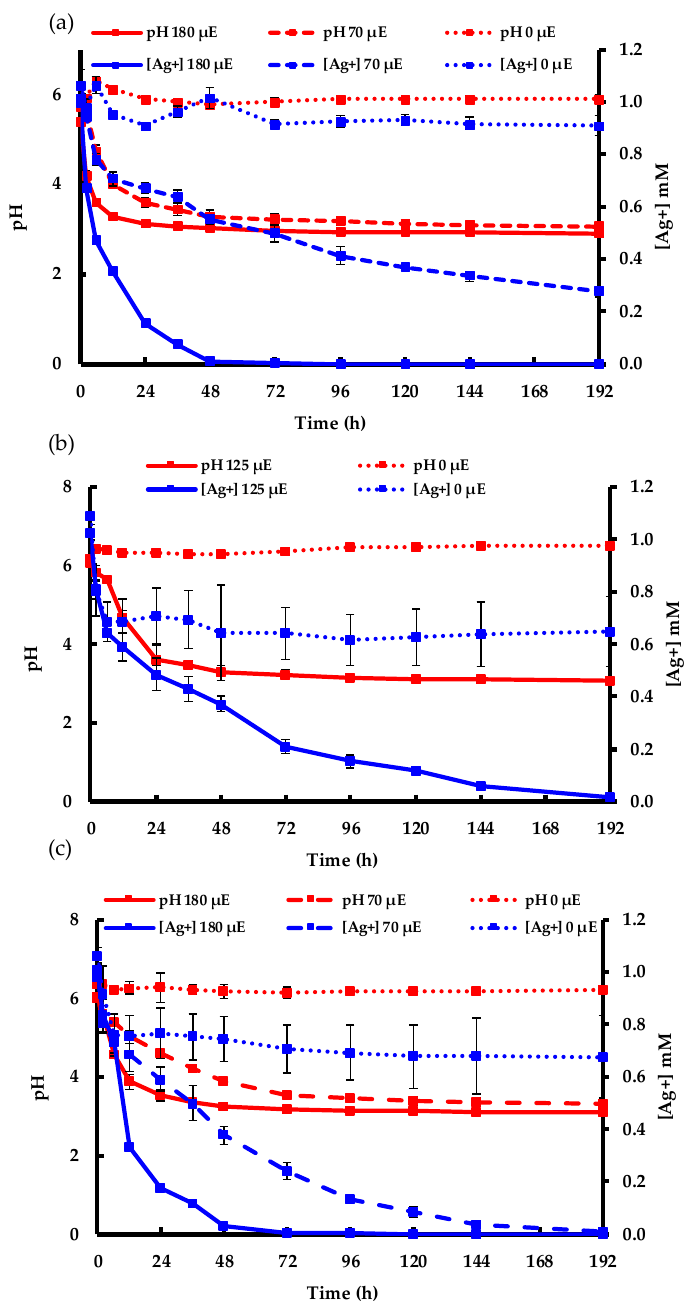
Figure 7. The change in pH and [Ag + ] vs. time after Ag + addition in the dark and under varying illumination intensities with EPS concentrations of: ( a ) 0.15 mg mL − 1 ; ( b ) 0.38 mg mL − 1 ; ( c ) 0.60 mg mL − 1